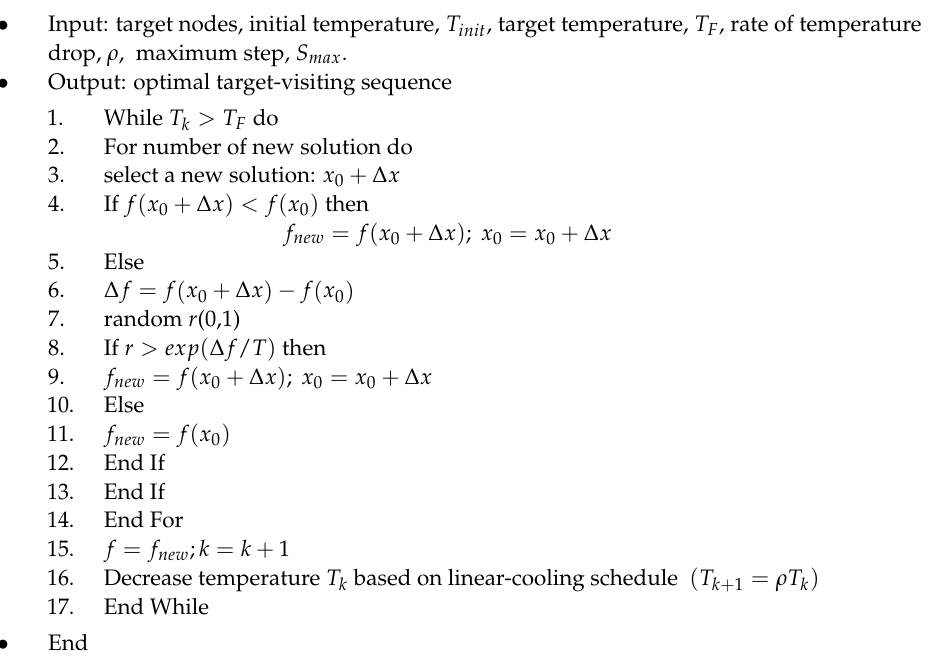
Algorithm 2 Simulated-Annealing